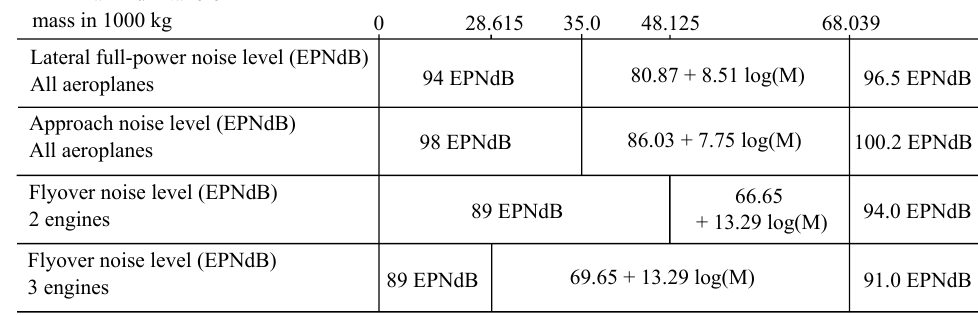
Figure 1. Noise limits on individual reference noise measurement points as proposed by FAA as a function of number of engines and maximum take-off mass (M). Table from the descriptions in Ref.